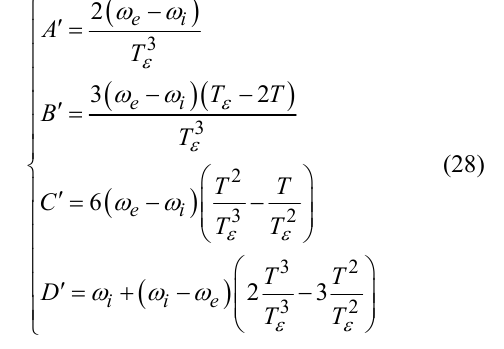
Figure 8. Piston displacement - case study